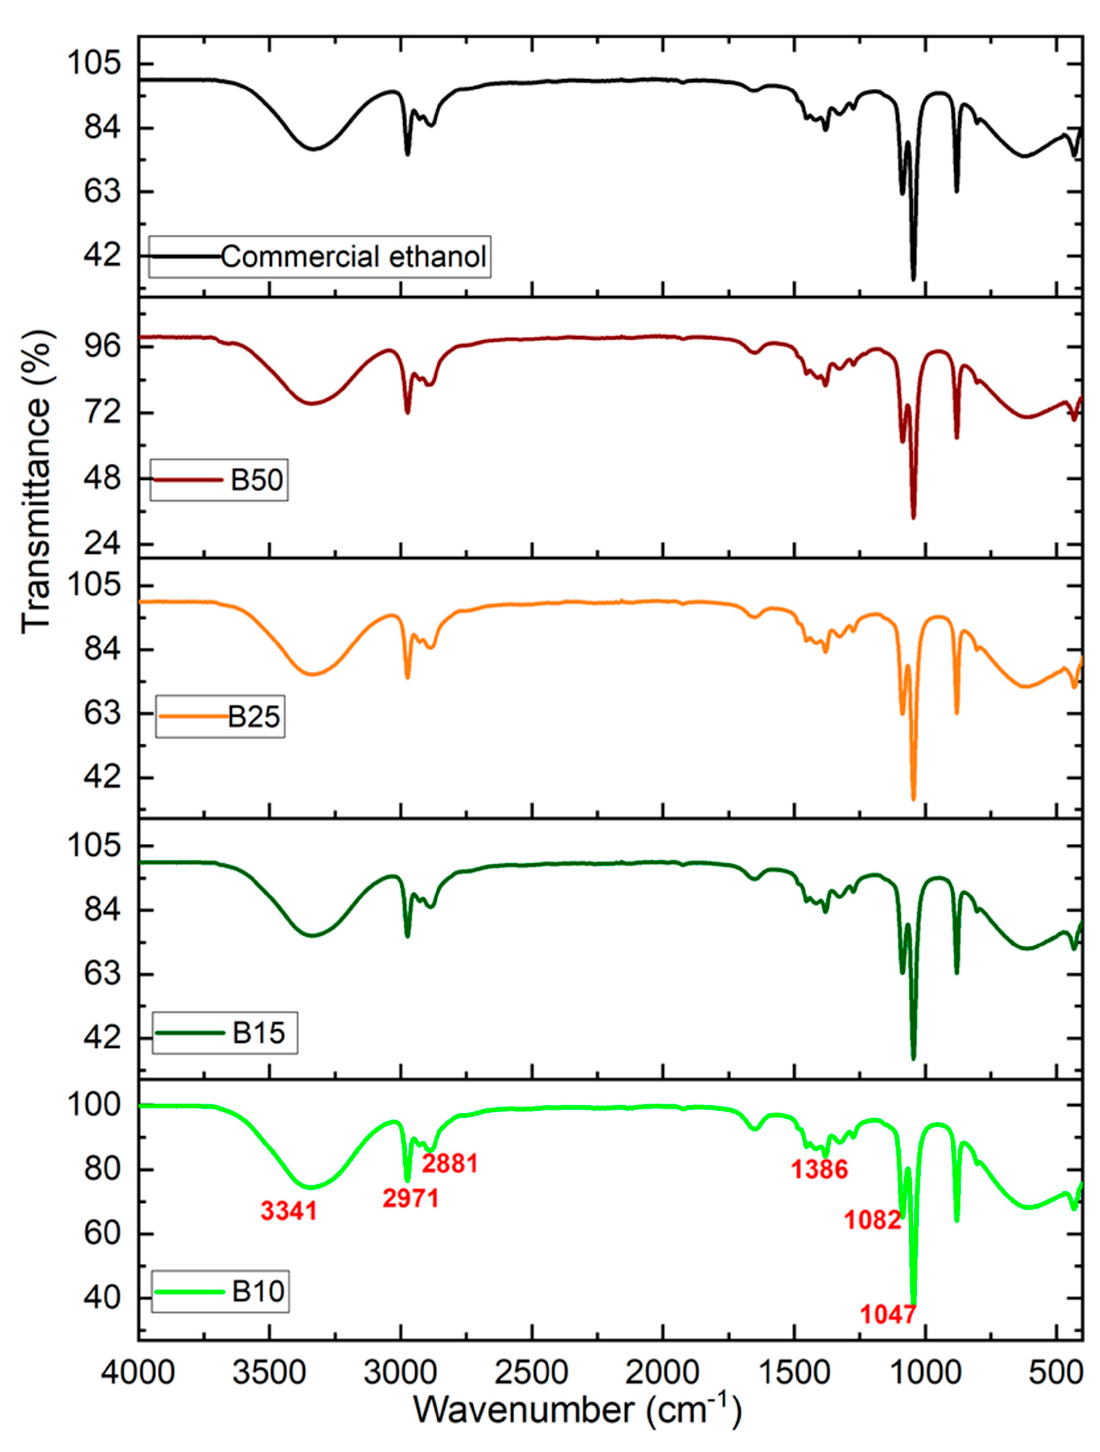
Figure 4. Infrared spectra of the commercial pure ethanol and the various produced bioethanol sam- ples.